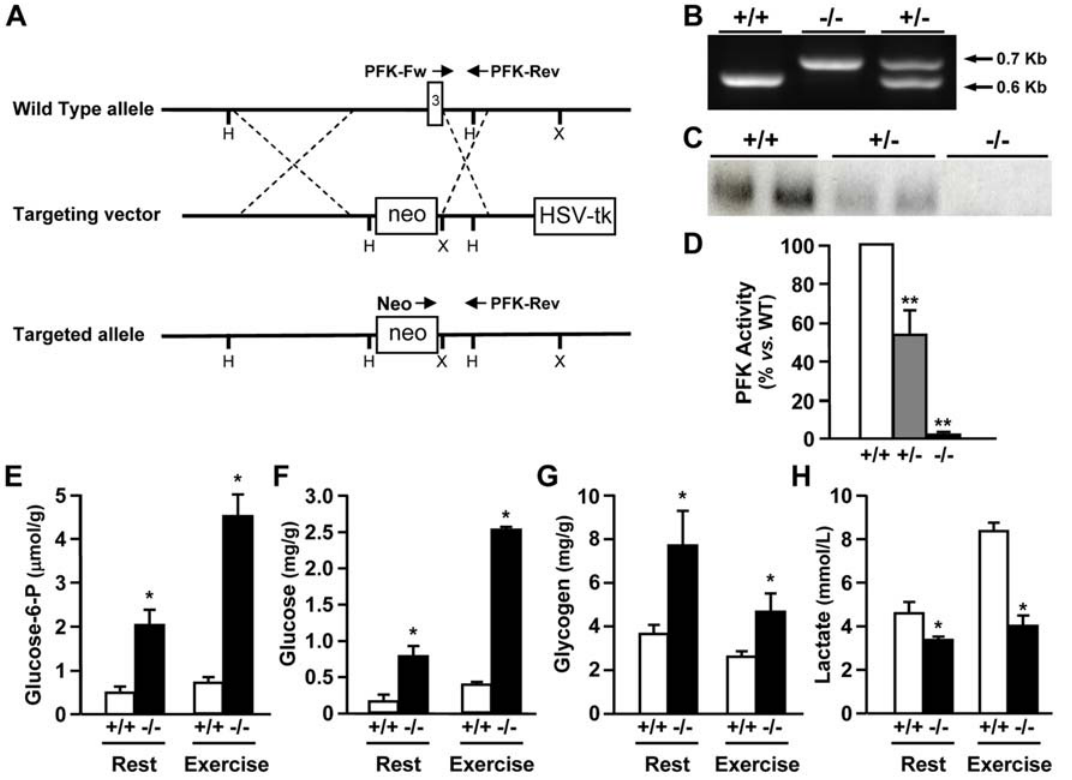
Figure 1. Generation of Pfkm 2 / 2 mice and the effect of Pfkm ablation on skeletal muscle glucose metabolism. (A) Schematic representation of the wild-type Pfkm locus (top), targeting vector (middle) and targeted allele (bottom). The positions of Hind III (H) and Xba I (X) cleavage sites, the neo R (neo) and herpes simplex virus thymidine kinase ( HSV-tk ) genes, and the location of PCR primers used to detect wild-type (PFK-Fw and PFK-Rev) and targeted (Neo and PFK-Rev) alleles are shown. (B) PCR analysis of DNA from wild type ( + / + ), Pfkm + / 2 ( + / 2 ) and Pfkm 2 / 2 ( 2 / 2 ) mice using the primers shown in (A). The 0.6 Kb band corresponds to the wild-type allele and the 0.7 Kb band to the mutant allele. (C) Expression of Pfkm in skeletal muscle. Total RNA was obtained from gastrocnemius muscle and analyzed by Northern blot. A representative Northern blot hybridized with a Pfkm probe is shown. (D) PFK activity was determined in skeletal muscle as indicated in Materials and Methods. Basal PFK activity in wild-type mice was 36 6 2.4 U/g tissue. (E–G) Glucose-6-phosphate (E), glucose (F) andglycogen (G) concentrations were determined in perchloric extracts of skeletal muscle from 2–3 month-old wild-type ( + / + ) and and Pfkm 2 / 2 ( 2 / 2 ) mice, in rest and after exercise (5 min), as indicated in Materials and Methods. (H) Serum lactate levels in wild-type ( + / + ) and Pfkm 2 / 2 ( 2 / 2 ) mice, in rest and after exercise (5 min). Results in D-H are mean 6 SEM of five to eight mice per group. * P , 0.05, ** P , 0.01 vs. wild-type.